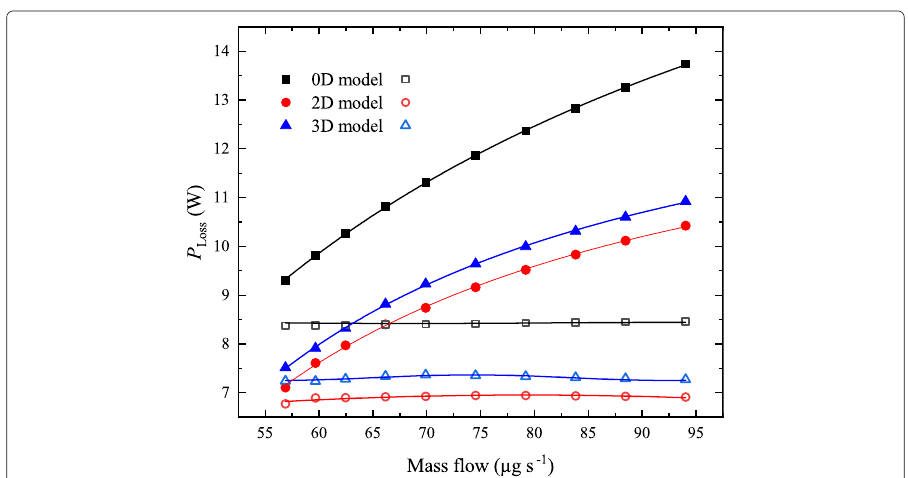
Fig. 13 Power lost due to excitation (full symbols) and ionization (empty symbols) as function of the mass flow, estimated by the three global